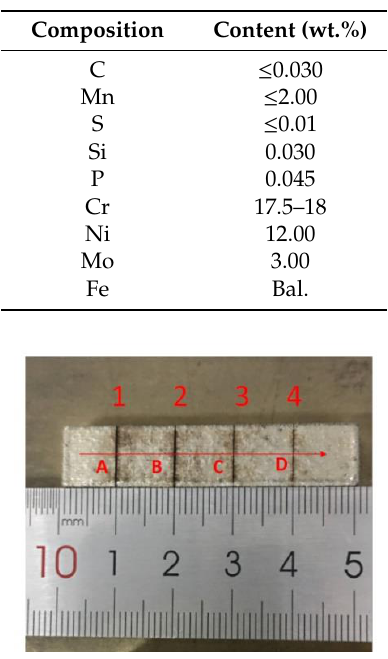
Figure 7. 316L austenitic stainless-steel sample made by LMD.